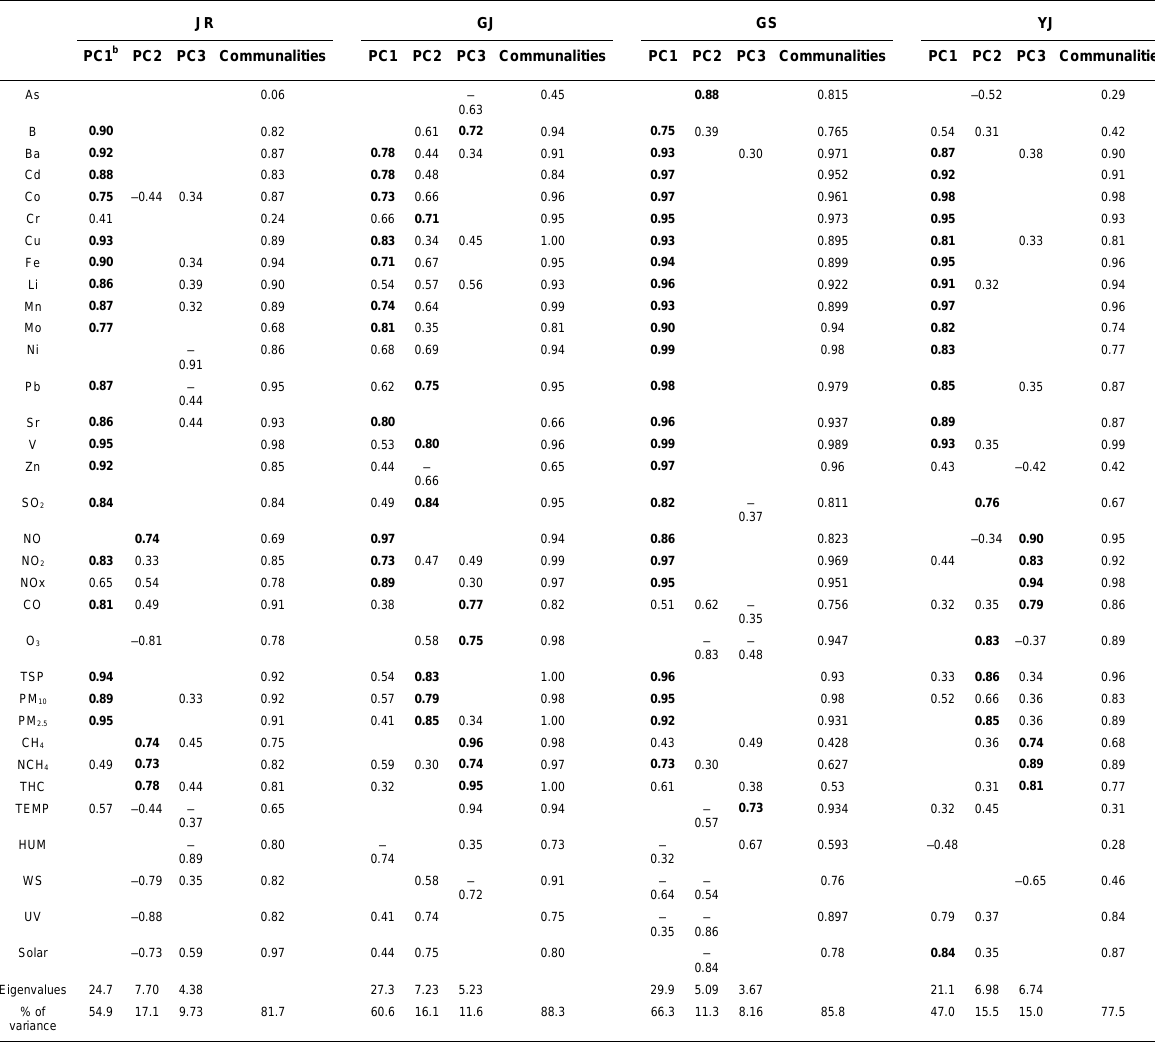
Results of Factor Analysis for Metals and Relevant Environmental Parameters at Each Station